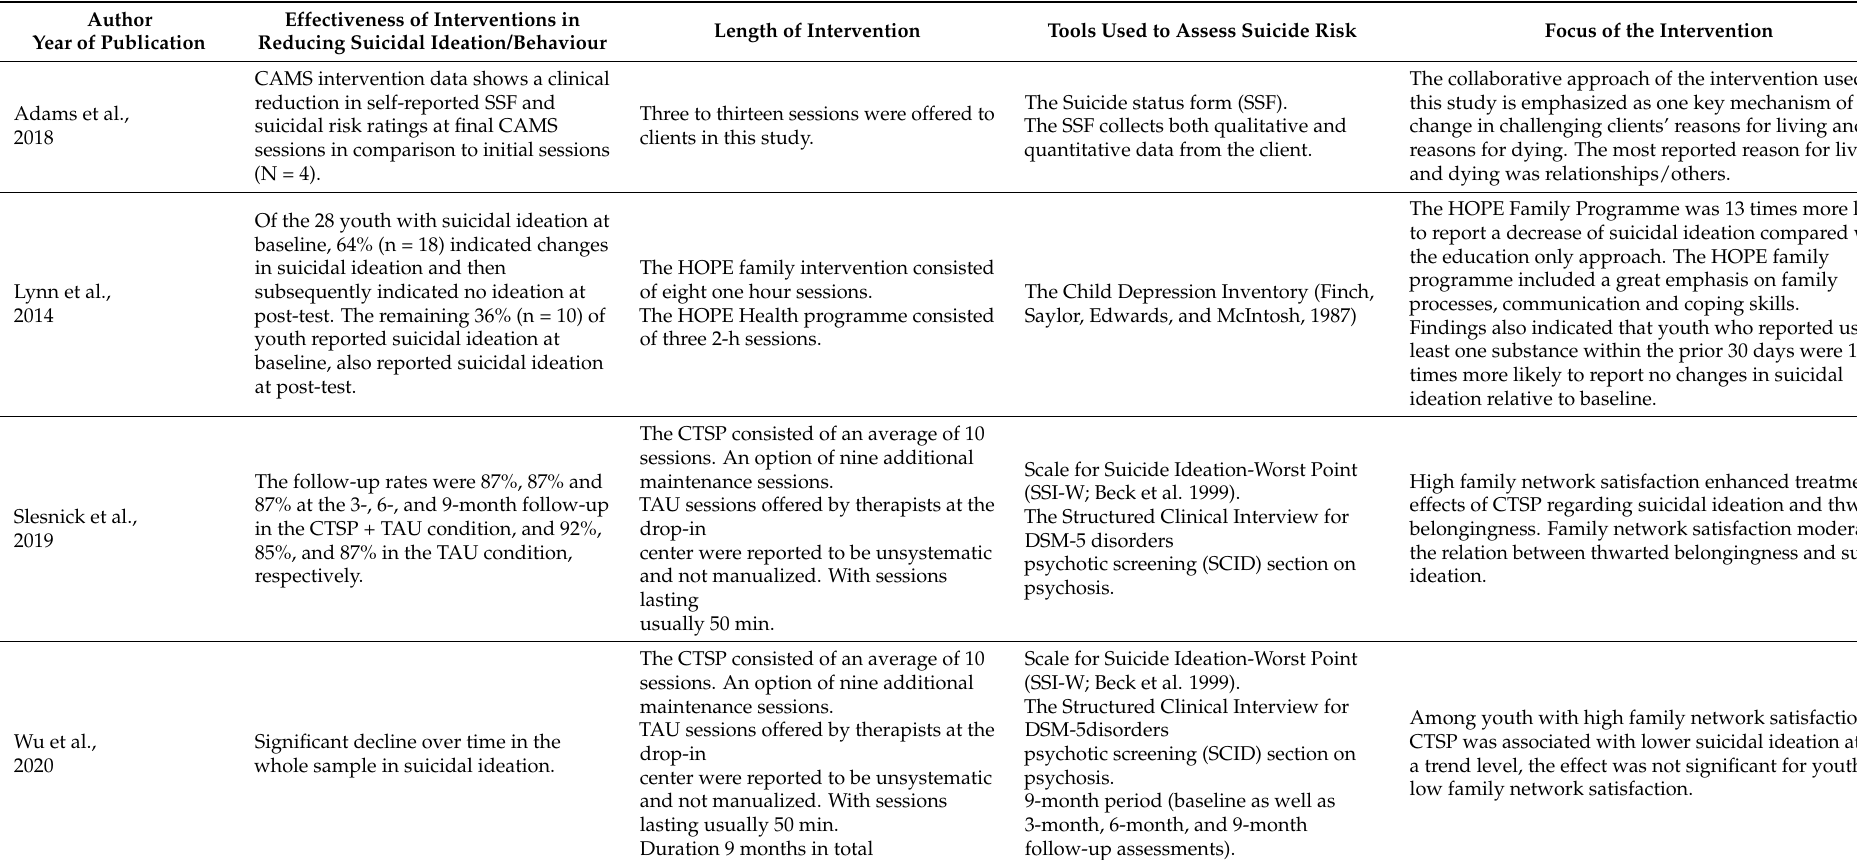
Table 4. Effectiveness of